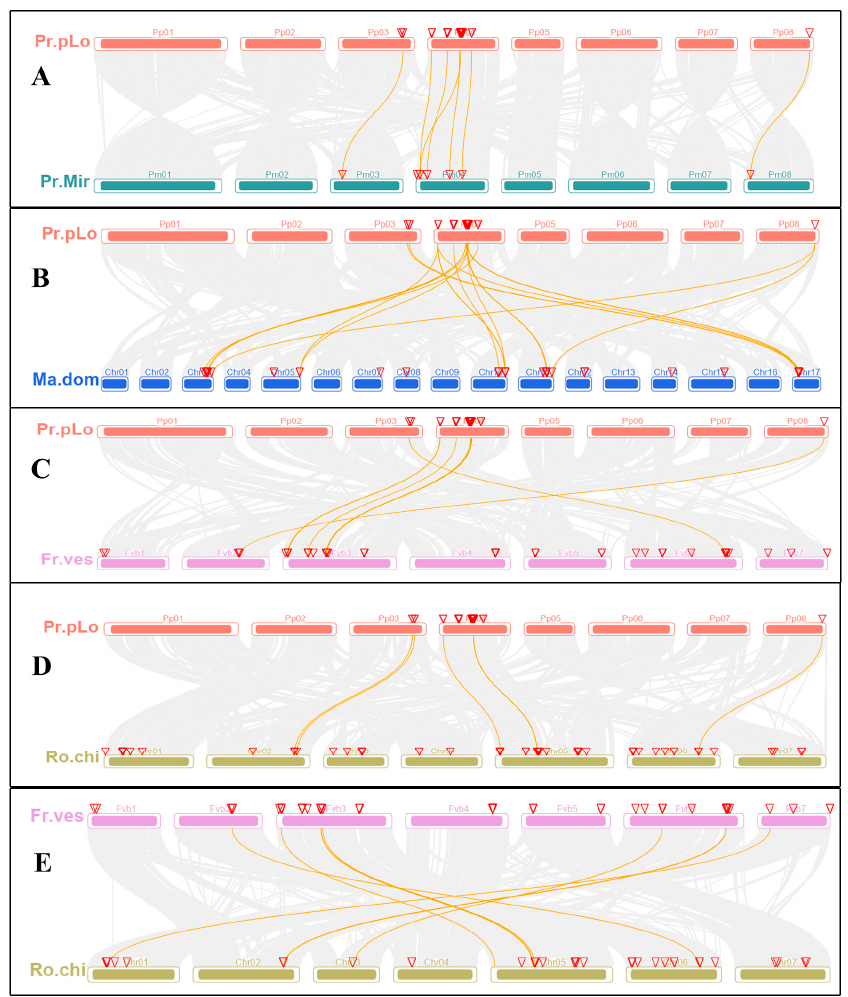
Figure 4. Inter-chromosomal relationships of TPSs in P. persica ( A ), M. domestica ( B ), and F. vesca ( C ). Grey lines in the circle indicate the collinear blocks in the P. persica or M. domestica genome. The red lines in the circle highlight the segmental duplicated TPS gene pairs, while the red curve outside the circle indicates the tandemly duplicated TPS gene pairs produced by MCSscanX.